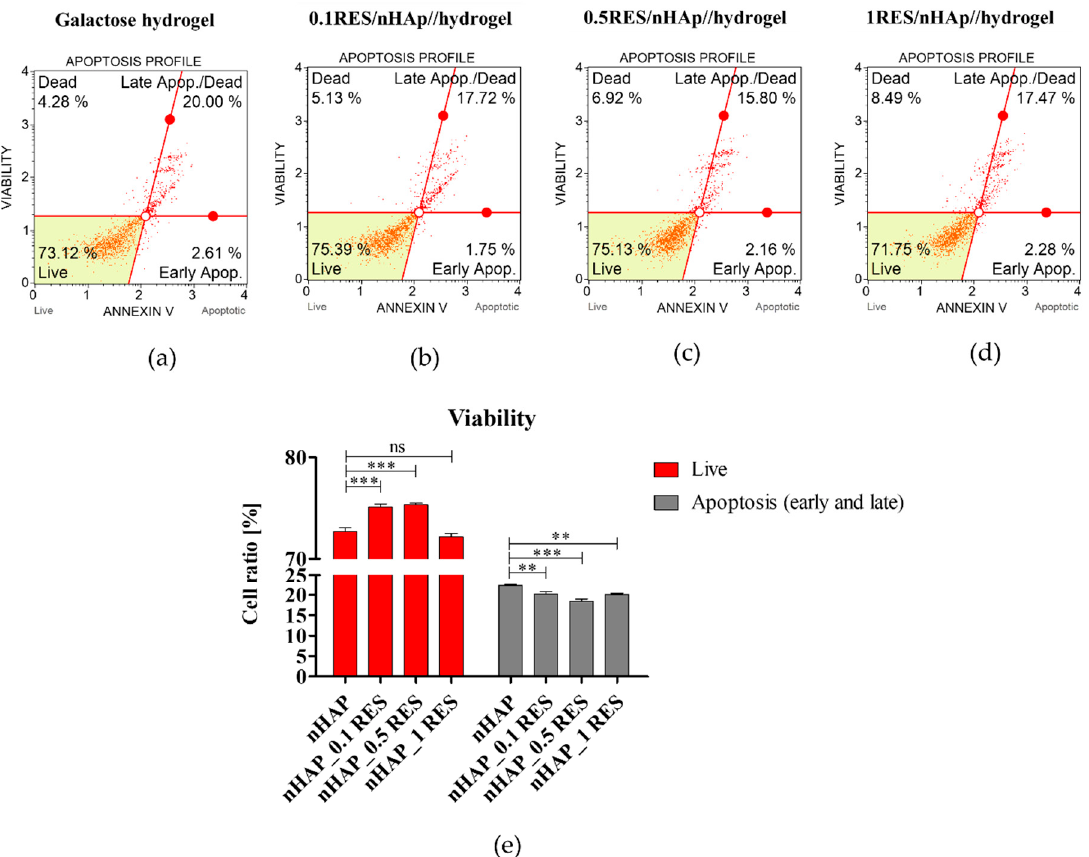
Figure 13. The influence of nHAp functionalized with resveratrol on cells viability. Representative images showing distribution of cells based on the viability noted in cultures with native hydrogel scaffold ( a ), and hydrogel functionalized with nHAp and 0.1 mM of resveratrol ( b ), 0.5 mM of resveratrol ( c ), and 1 mM of resveratrol ( d ). The statistical analysis of obtained results was performed ( e ), and significant changes are indicated with asterisks, (**) p < 0.01 and (***) p < 0.001, while non-significant differences are marked as ns .